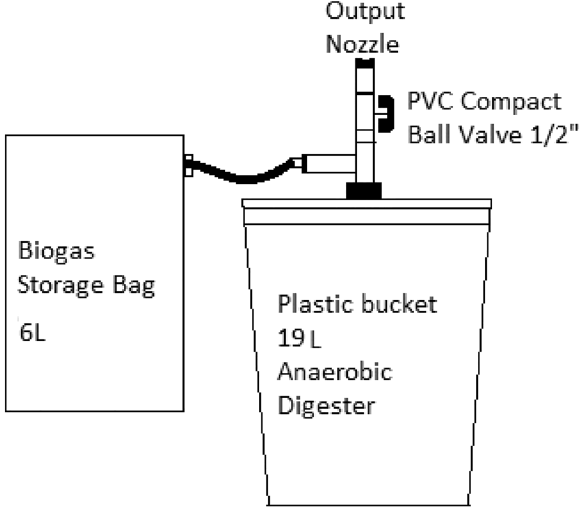
Fig. 1 Schematic of the UNAPEC´s batch system biodigestors "BioBuckets" (Santo Domingo,